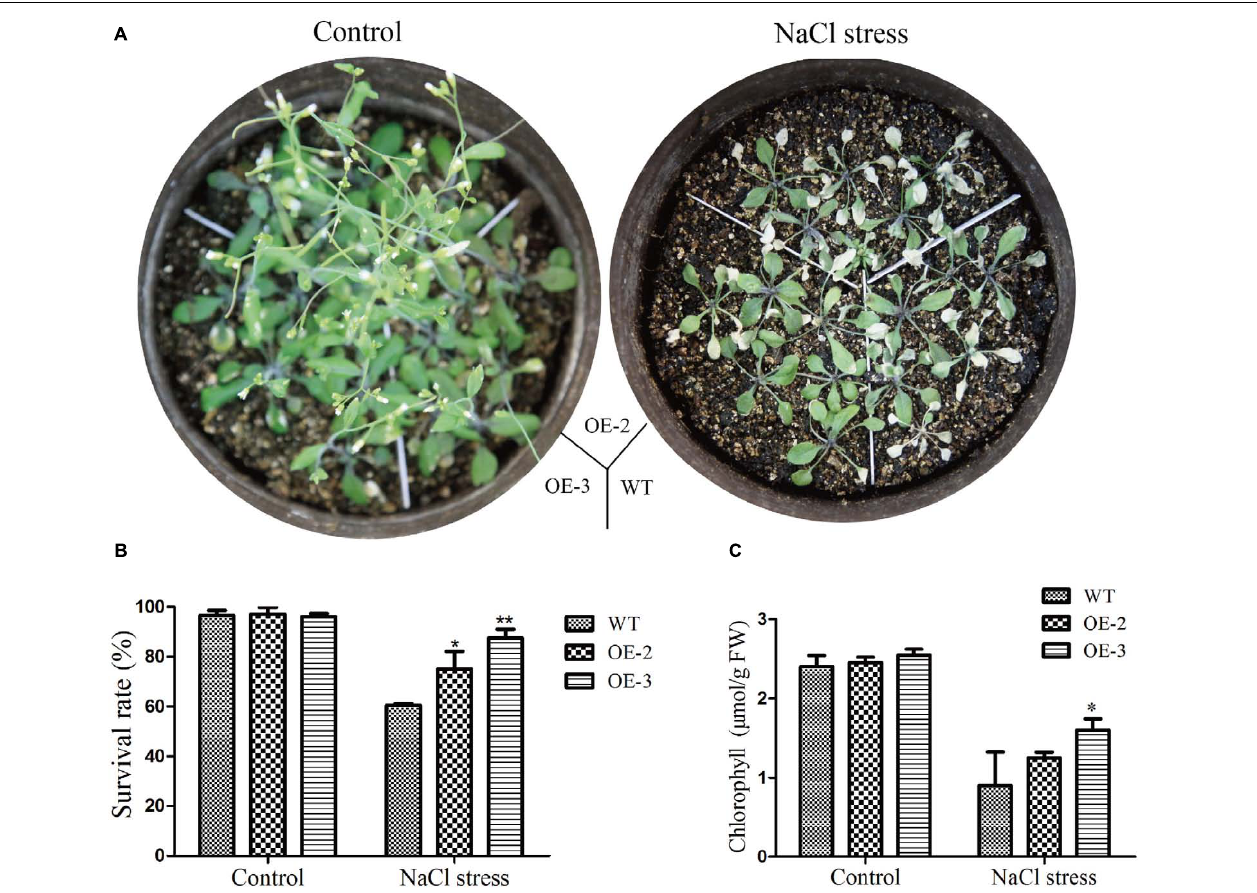
FIGURE 11 | Phenotype assay of the GmRAV-03 overexpression transgenic Arabidopsis grown in soil under NaCl stress. (A) Phenotype of the GmRAV-03 overexpression transgenic Arabidopsis and WT grown in soil under NaCl stress . (B) Survival rate of the GmRAV-03 overexpression transgenic Arabidopsis and WT under NaCl stress. (C) Chlorophyll content of the GmRAV-03 overexpression transgenic Arabidopsis and WT under NaCl stress. 0.1 g leaves were used to extract chlorophyll. The data are shown as mean ± SD ( n = 45). Independent t -tests demonstrated that there was (very) significant difference ( ∗ P < 0.05 or ∗∗ P <